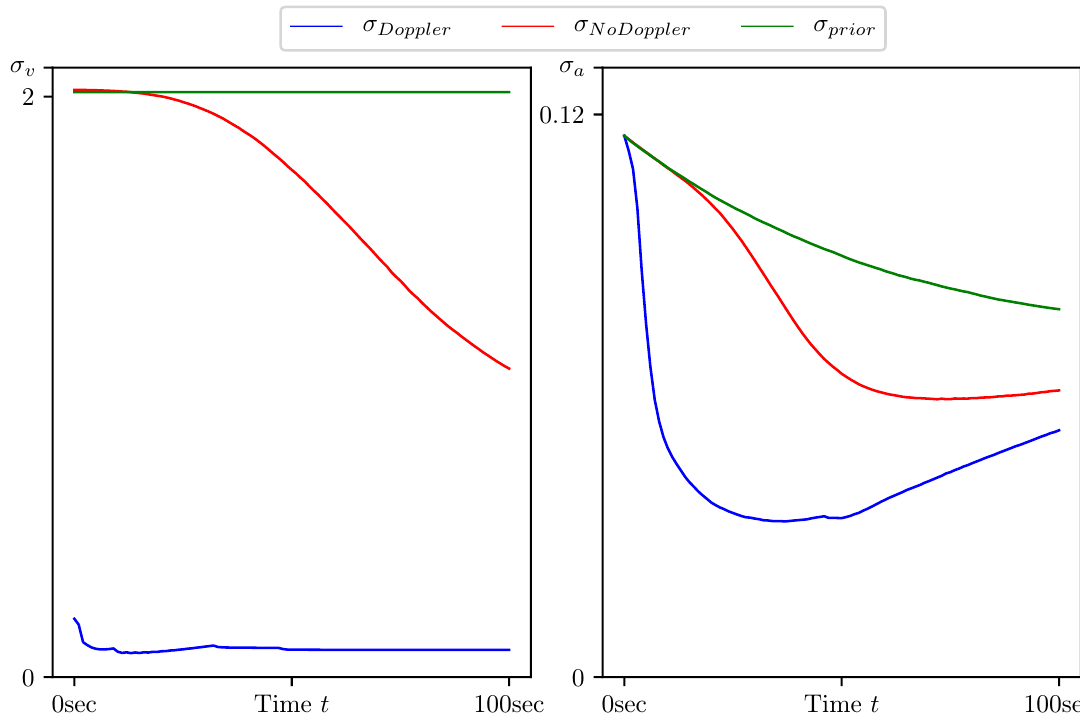
Figure 7. Standard deviation of estimation error for the target heading speed and normal acceleration ( v t , a n ) calculated by CMNF filter with and without Doppler measurements, and their a priori estimates. t